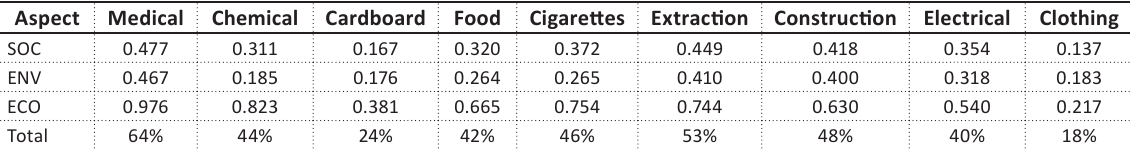
Source: Study data.